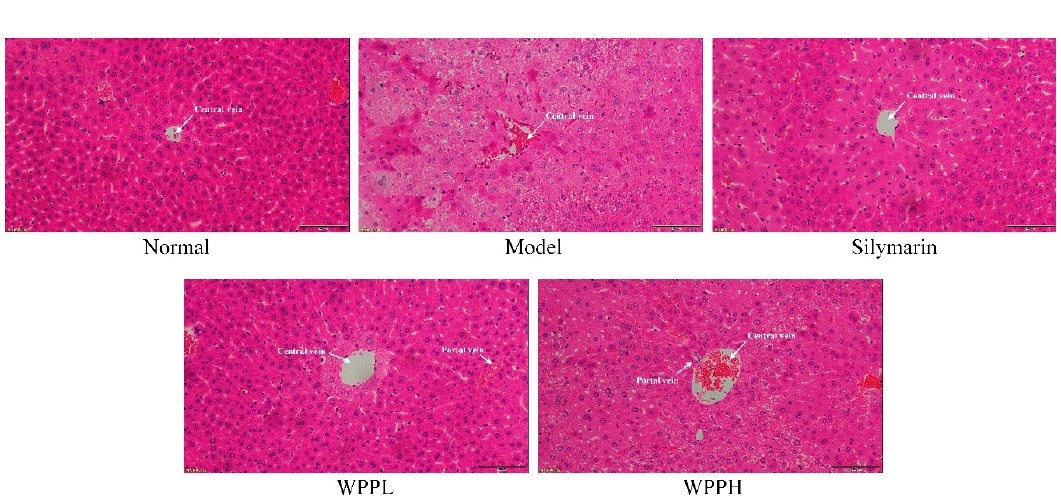
Table 6. Neuronal nitric oxide synthase (nNOS), endothelial nitric oxide synthase (eNOS), and inducible nitric oxide synthase (iNOS) mRNA expression in the hepatic tissues of the mice ( N = 10). GAPDH nNOS eNOS iNOS Group Expression Expression Normal